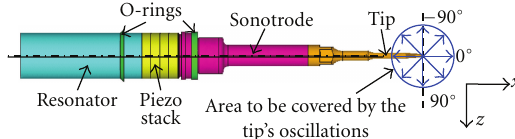
Figure 1: Dental ultrasonic scaler (upper view).